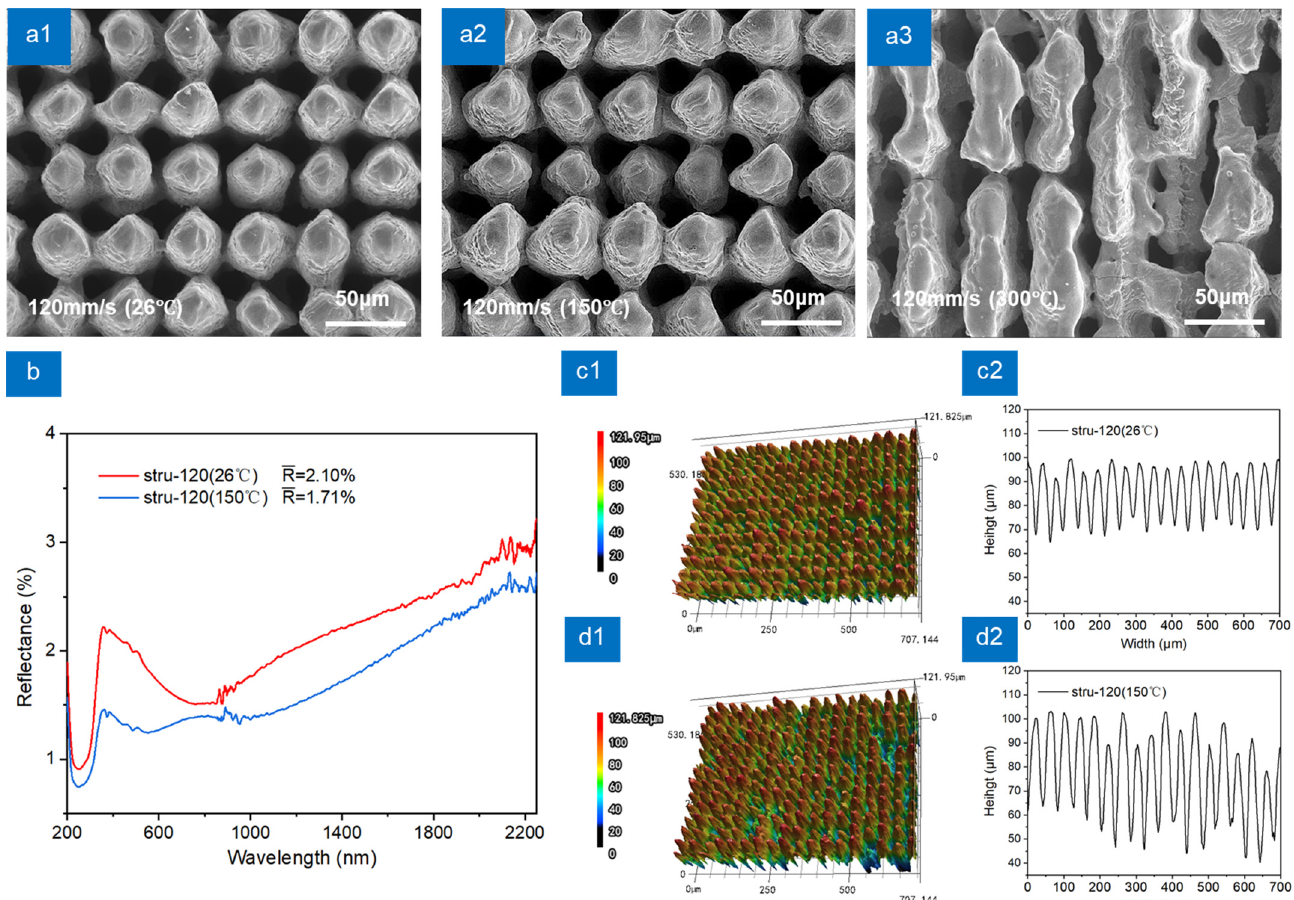
Figure 5. Reflection spectra and topographic images of multi-scale structures at thermal-assisted strategy. ( a1 – a3 ) SEM images of multi-scale structures at different thermal-assisted temperatures: ( a1 ) 26 ◦ C, ( a2 ) 150 ◦ C, ( a3 ) 300 ◦ C, ( b ) Reflectance spectra of stru-120 (26 ◦ C) and stru-120 (150 ◦ C), ( c1 , c2 ) LCM image and cross-sectional view of stru-120 (26 ◦ C), ( d1 , d2 ) LCM image and cross-sectional view of stru-120 (150 ◦